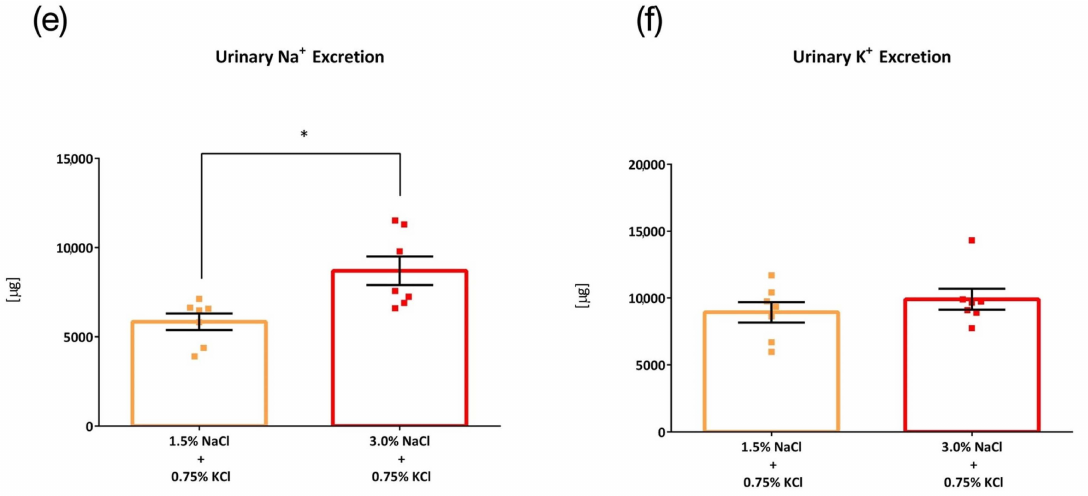
Figure A1. Urinary Excretion after administration of 1.5% NaCl + 0.75% KCl and 3.0% NaCl